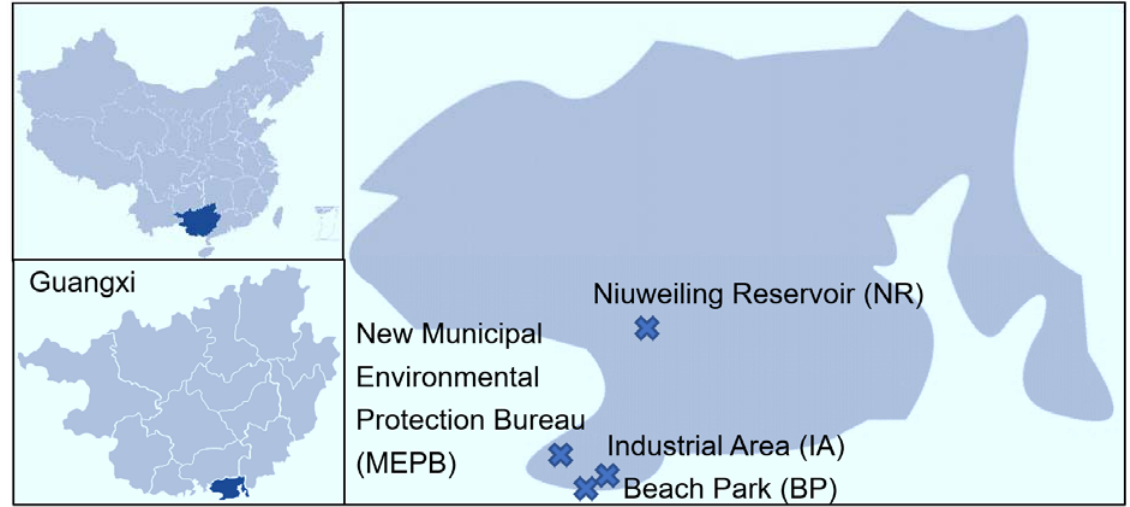
Figure 1. General view of the study area and the location of the national monitoring stations.